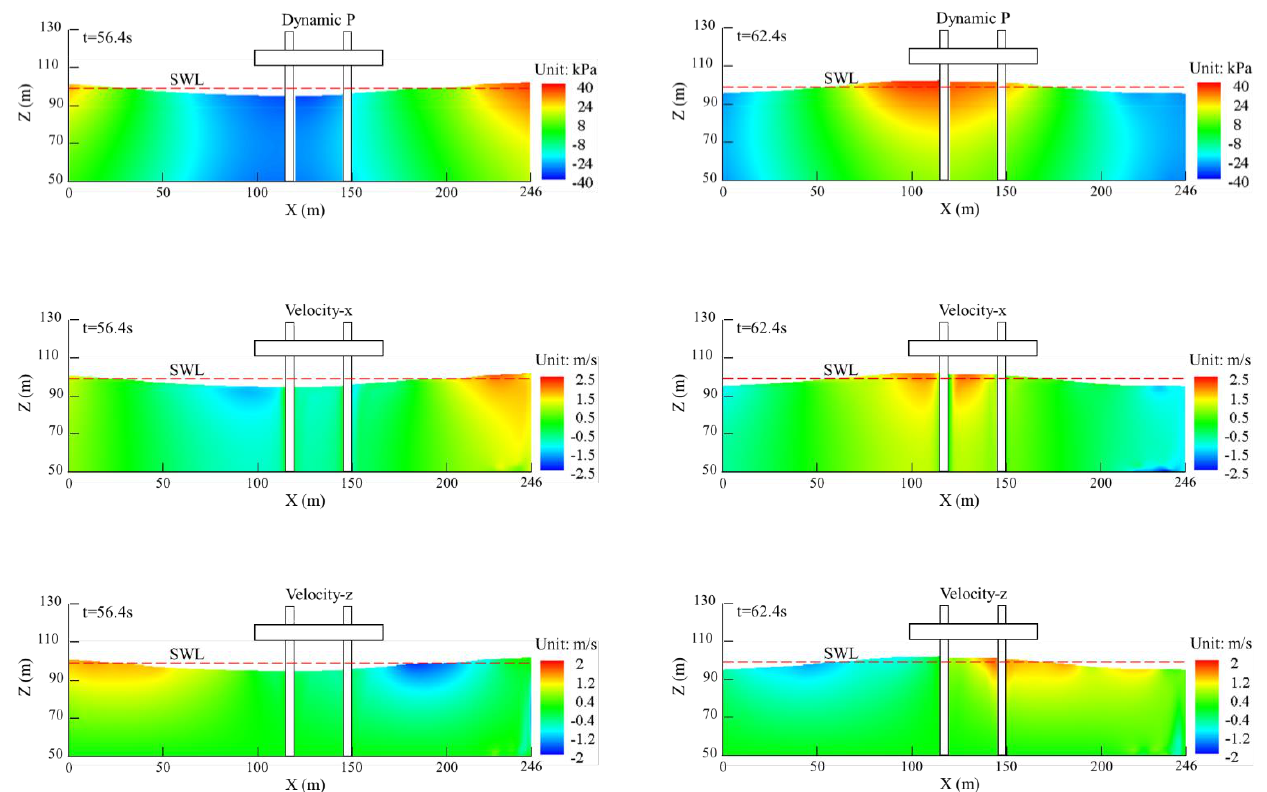
Figure 6. Distribution of the wave-induced pressure and velocity at t = 56.4 s and t = 62.4 s around the offshore platform on the section Y = 50 m in Case 1 ( H = 7 m, d = 50 m, T = 15 s).